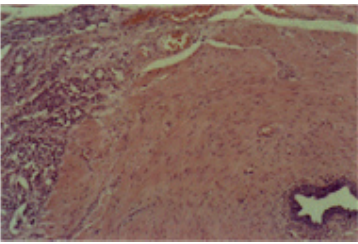
FIGURE 1 . Prostatic adenocarcinoma infiltrating the efferent ductules of the testis/epididymal lobules. x200 Hematoxylin & Eosin stain.